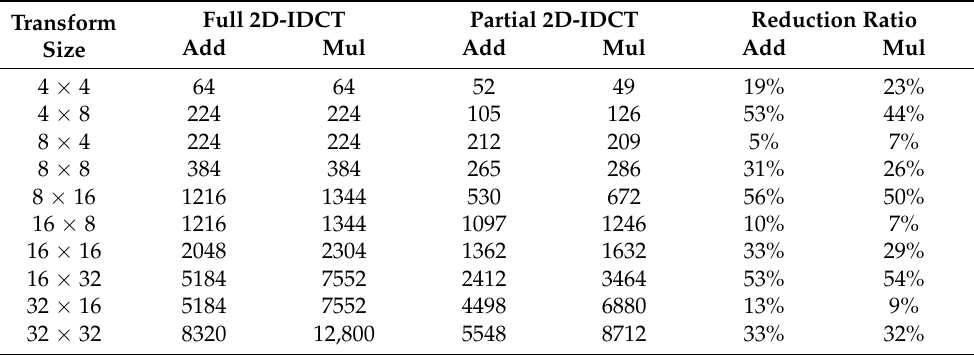
Figure 5. Partial reconstruction flow of the butterfly structure for a 16-point 1D inverse discrete cosine transform (ID-IDCT). Table 2. The numbers of additions (Add) and multiplications (Mul) of the full and partial inverse transformations.